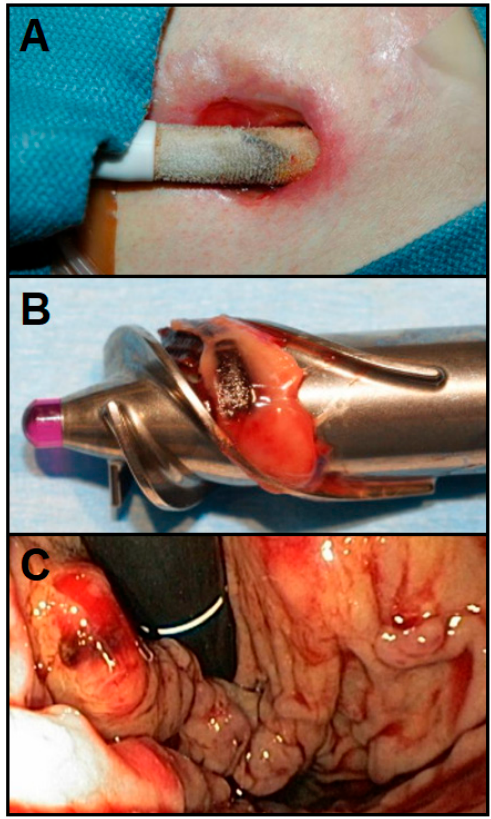
Figure 5. Some of the most longstanding complications after left ventricular assist device (LVAD) implantations are driveline infections ( A ), pump thrombosis ( B ), and gastrointestinal bleeding ( C ) [83–85].